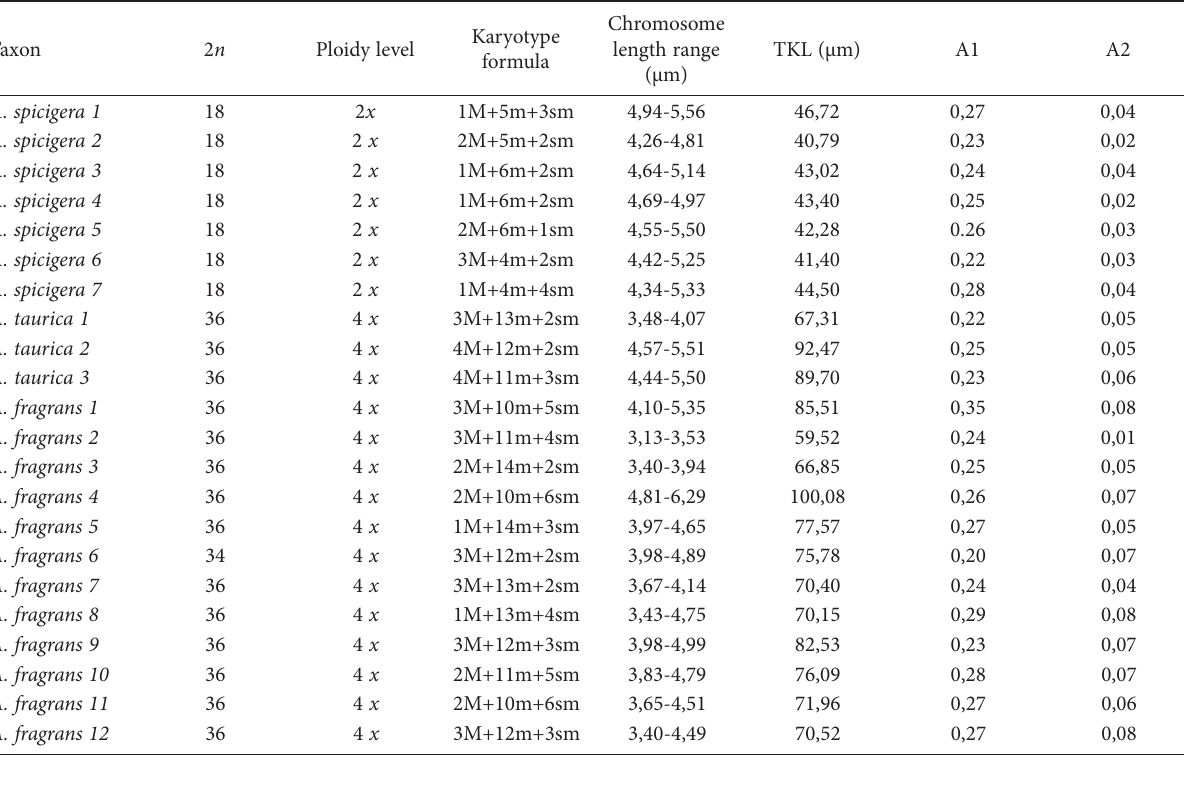
Table 2. Somatic chromosome numbers (2 n ), ploidy level, karyotype formula, ranges of chromosome length, total karyotype length (TKL), and asymmetry indexes (A1, A2) of the studied taxa.